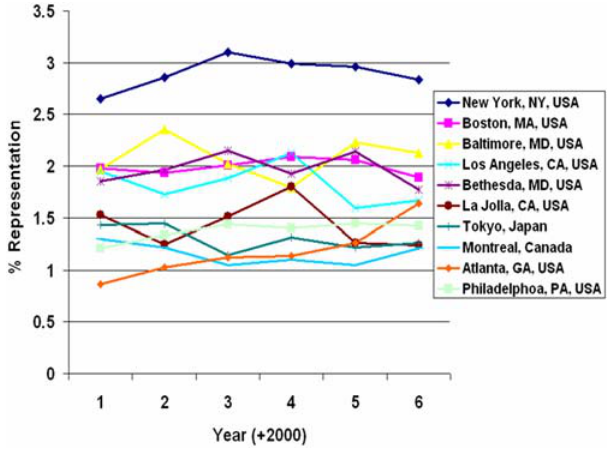
Figure 1. Changes in the percentage of raw numbers of abstract authors for several geographical locations between the year 2001 and 2006.